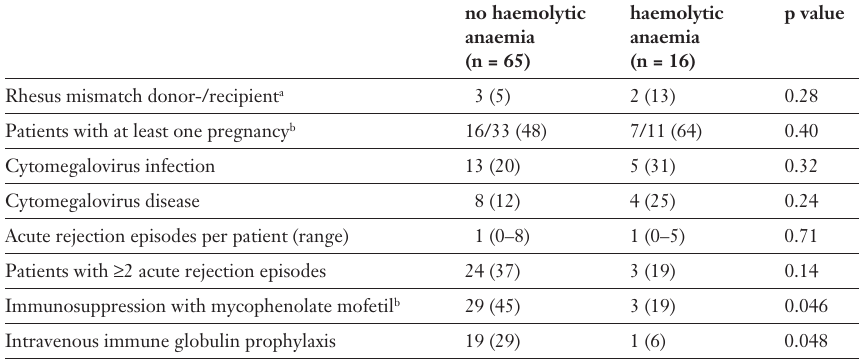
Comparison of possible factors associated with the development of posttransplant haemolytic